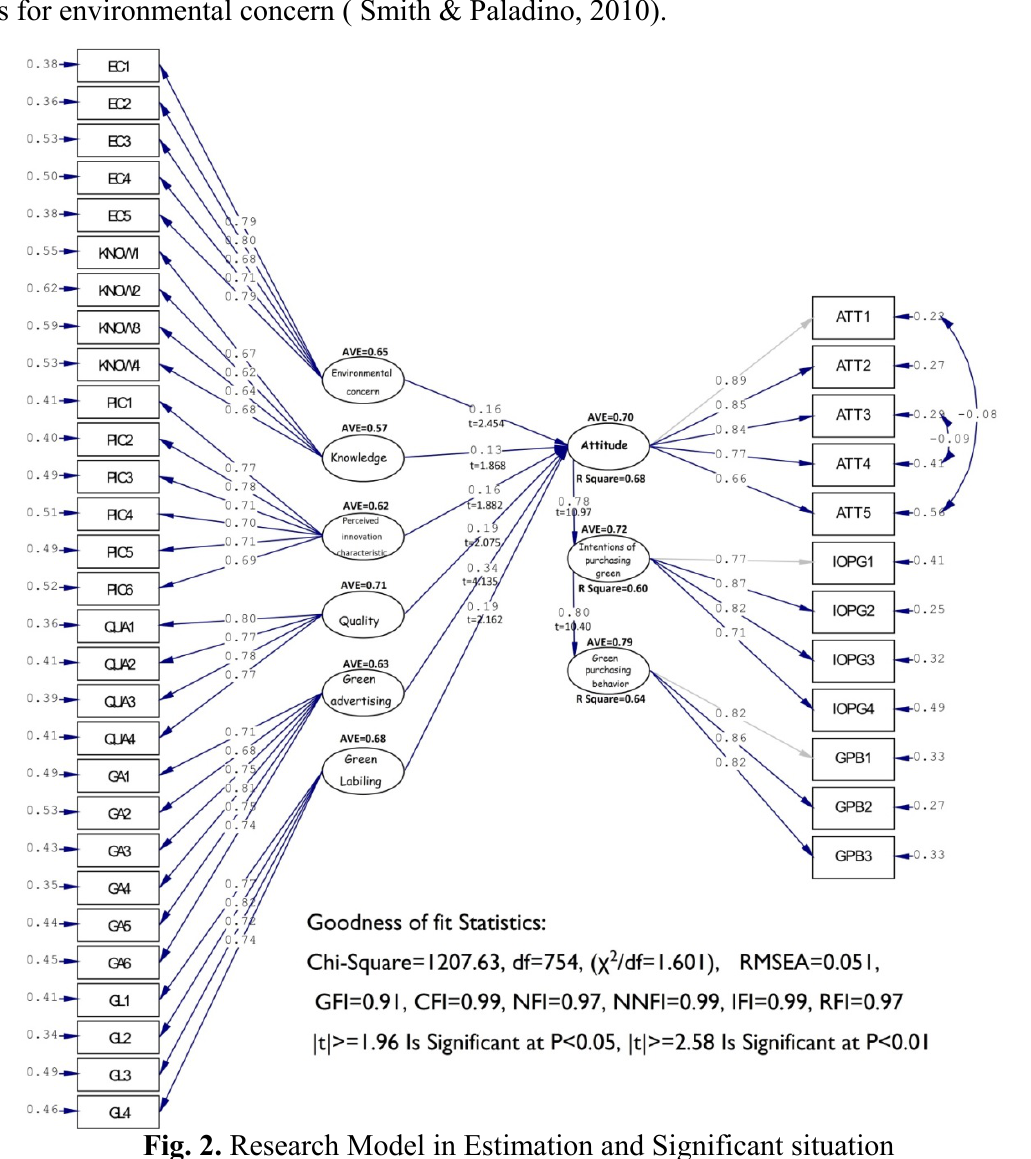
Fig. 2. Research Model in Estimation and Significant